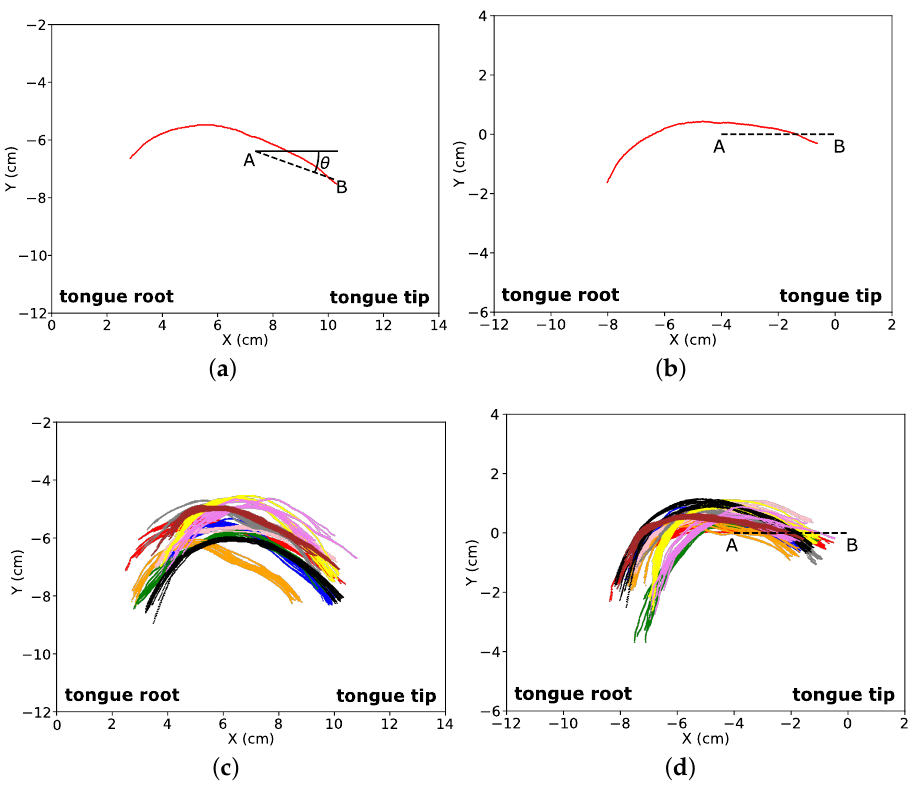
Figure 4. Example of unrotated ( a ) and rotated ( b ) tongue tracing of one sustained vowel [a] (top). Tongue contour of each sustained vowel [a] of all speakers unrotated ( c ) and rotated ( d ) (bottom). The dashed line represents the annotation of the bite